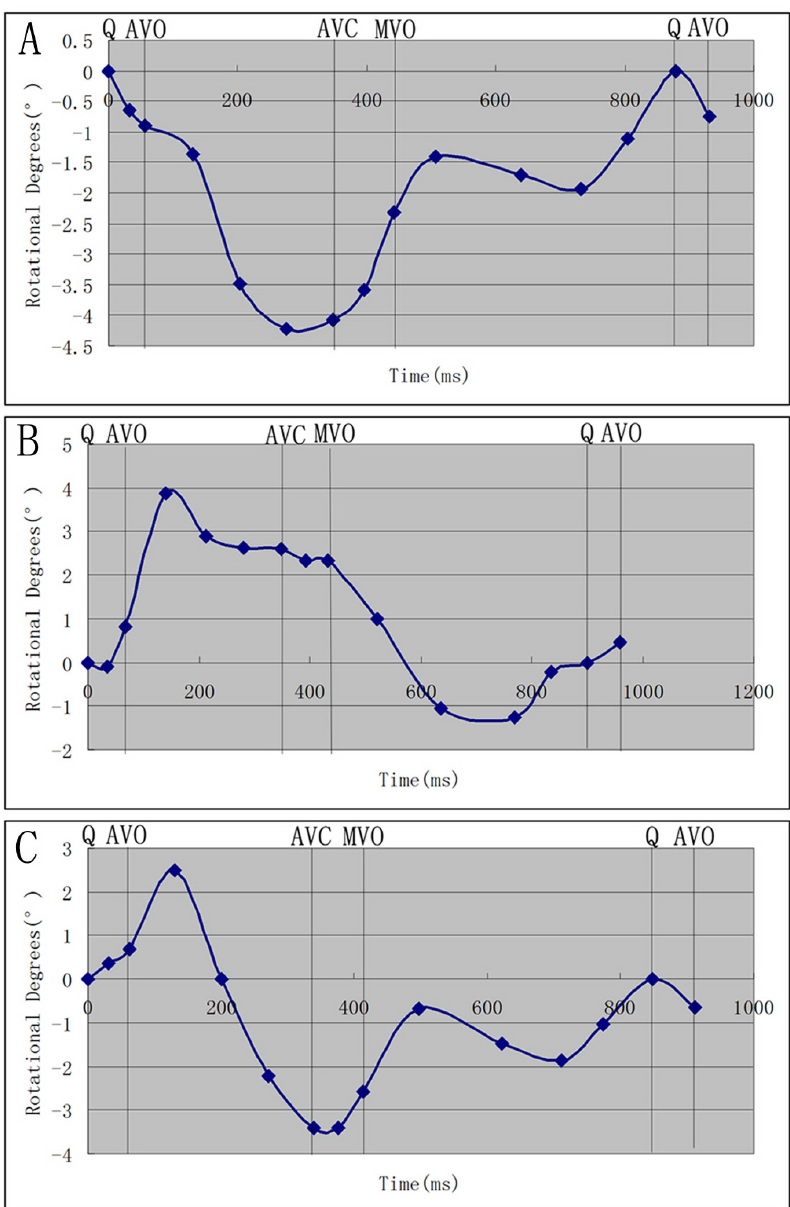
Figure 3. Three rotation patterns at the papillary muscle short-axis levels, Figure 3A is clockwise rotation, Figure 3B is counterclockwise rotation, and Figure 3C is counterclockwise to clockwise rotation.